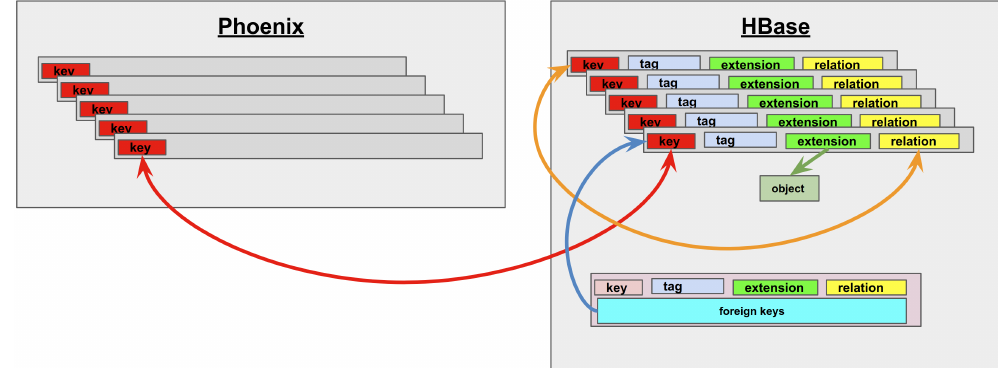
Figure 1. Schema of the Prototype 2